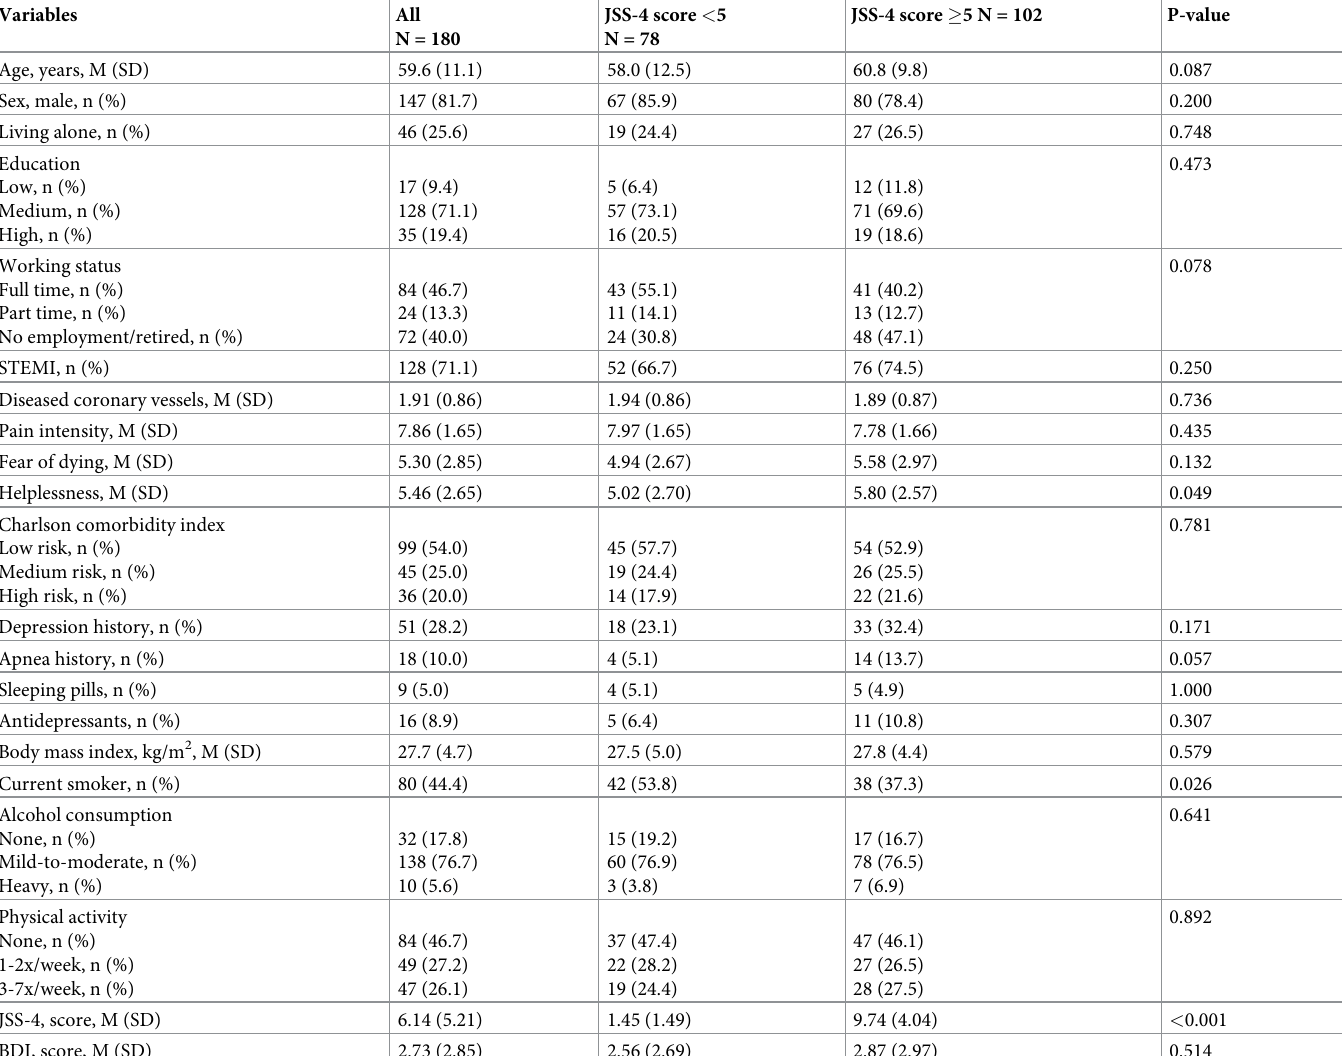
Table 1. Characteristics of study participants at